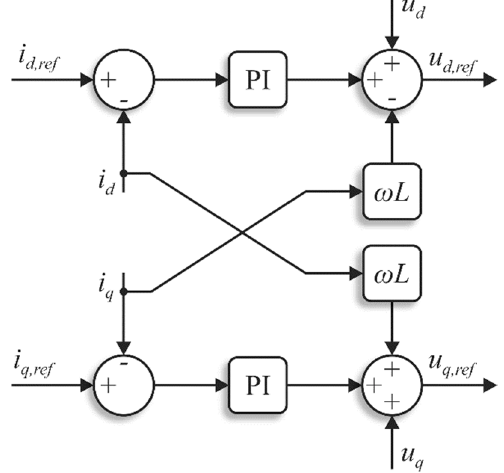
Figure 2. Current control block.